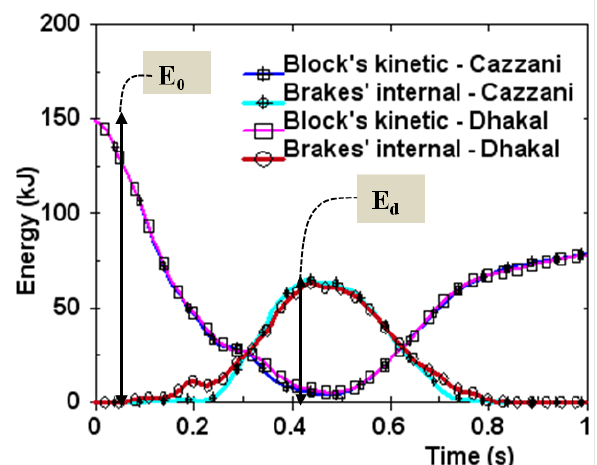
Figure 18. Numerically simulated time histories of energy dissipation by the proposed 2 Fig. 18. Numerically simulated time histories of energy dissipa- tion by the proposed Cazzani-LPR Brake Model and Dhakal-LPR Cazzani-LPR Brake Model and Dhakal-LPR Brake Model devices integrated separately into 3 Brake Model devices integrated separately into the R-LPR, when the R-LPR, when subjected to the designated impact energy of 150 kJ. The energy dissipating 4 subjected to the designated impact energy of 150kJ. The energy dissipating efficiency (E d /E 0 ) of the brakes is about 43.36% in the efficiency (E d /E 0 ) of the brakes is about 43.36 % in the case of the Cazzani-LPR Brake Model 5 case of the Cazzani-LPR Brake Model and 42.36% in the case of and 42.36 % in the case of the Dhakal-LPR Brake Model. The maximum (out-of-plane) 6 the Dhakal-LPR Brake Model. The maximum (out-of-plane) dis- placement response in each case was read approximately the same, displacement response in each case was read approximately the same, about 3.9m. 7 about